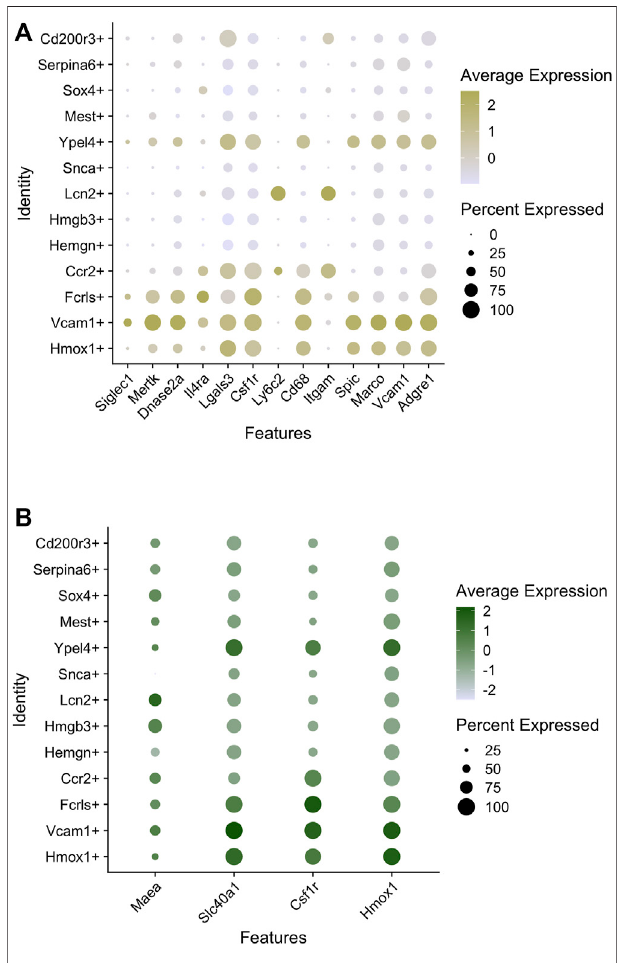
FIGURE2| Macrophagemarkerexpressioninsubpopulationsofmouse E13.5 FL macrophages. (A) Bubble-plots showing the expression level of macrophage markers enriched in certain subpopulations. The intensity of the color indicates expression level of each gene whereas the size of the bubble depicts the relative fraction of cells in that subpopulation where the gene is expressed. (B) Bubble plots showing macrophage markers with similar levels of expression in most